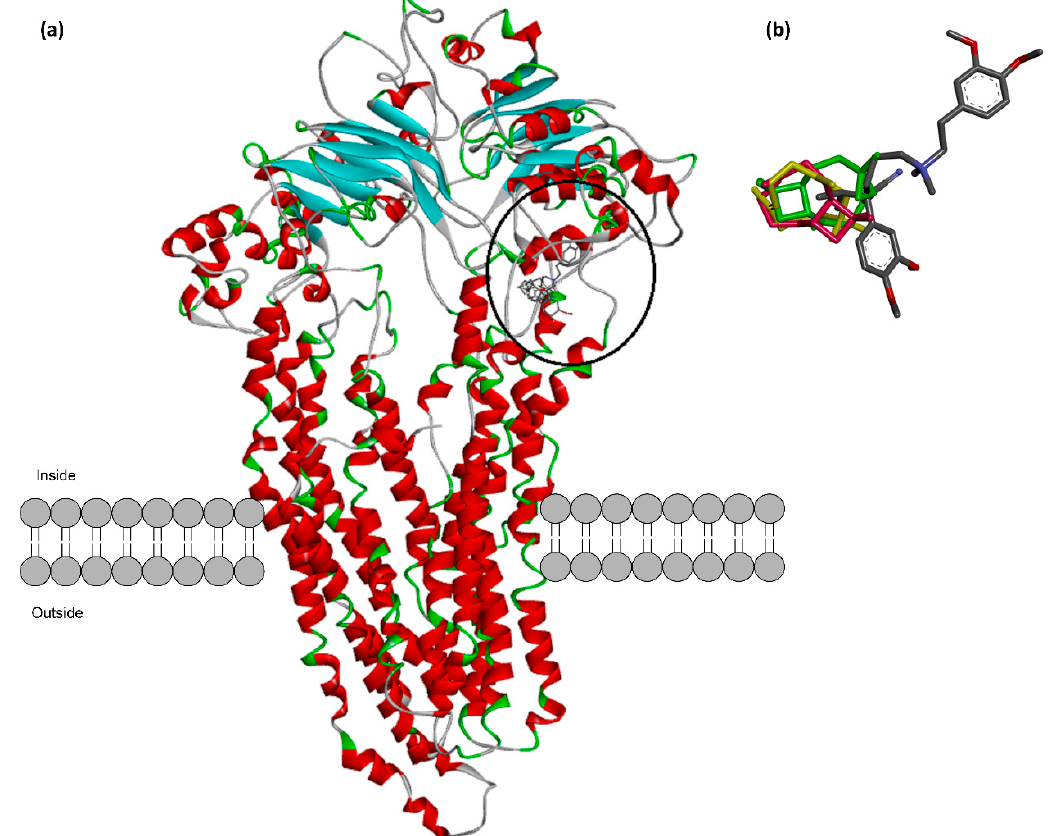
Figure 8. Predicted active site has been circled in the figure for the caryophyllane sesquiterpenes. ( a ) The common binding site predicted for verapamil and the caryophyllane sesquiterpenes is shown as circled. ( b ) Binding conformation of verapamil (colored by atom), α -caryophyllene (yellow), β -caryophyllene (red) and β -caryophyllene oxide (green).